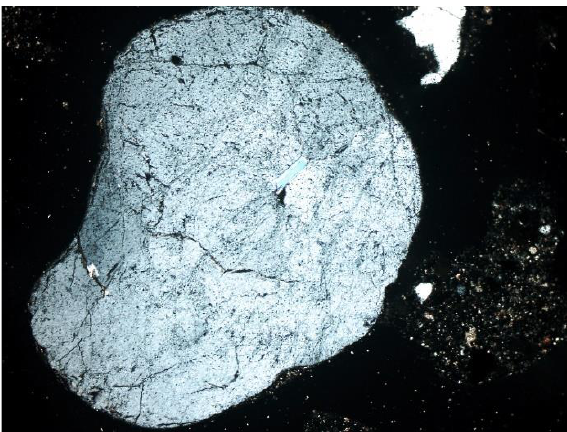
Figure 6. Quartz grain with embedded apatite (SP1 sample), thin section, 2P, 200×, transmitted light.